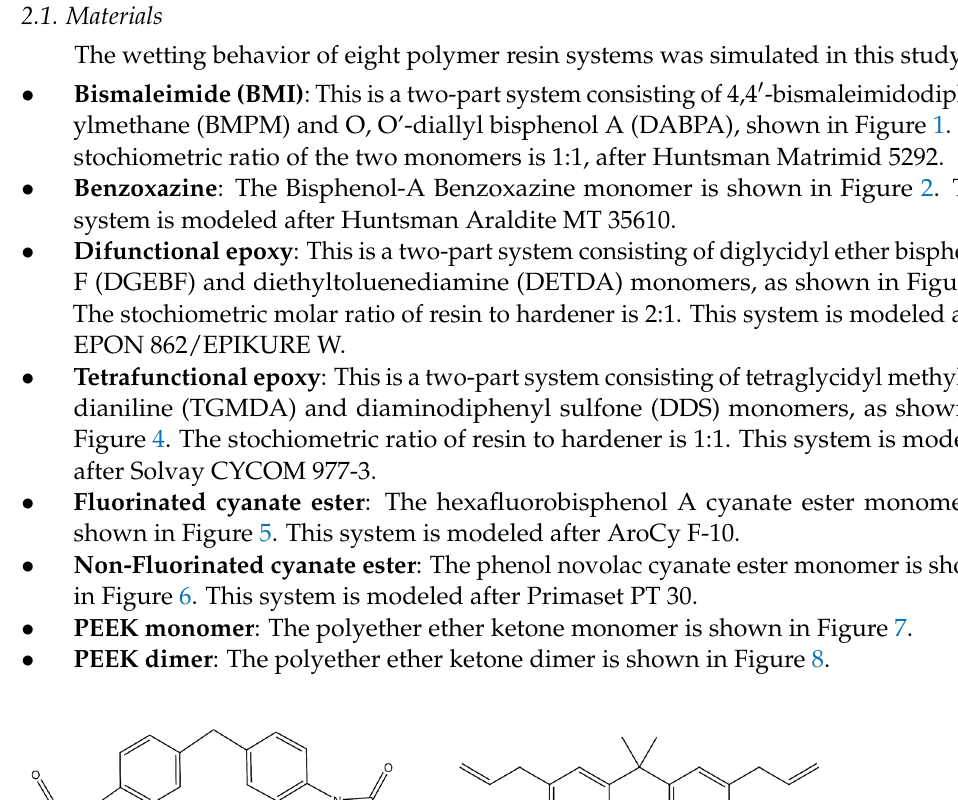
Figure 2. Molecular structure of benzoxazine.